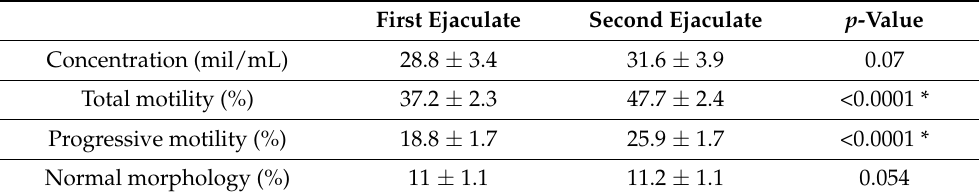
Table 3. Sperm parameters (mean ± SEM) of the two ejaculates of the male partners in Group 2 couples ( n =